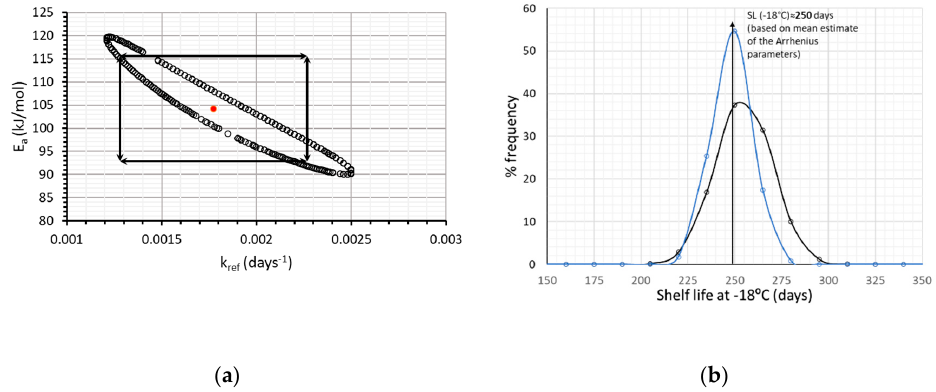
Figure 3. ( a ) Joint Confidence Intervals, depicting the correlation between parameters E a and k ref and ( b ) Shelf Life estimated at − 18 °C, taking into account the correlation of the two kinetic parameters (). Black line represents the SL distribution without considering E a -k ref correlation, blue line after excluding the E a -k ref pairs of Figure 3a.